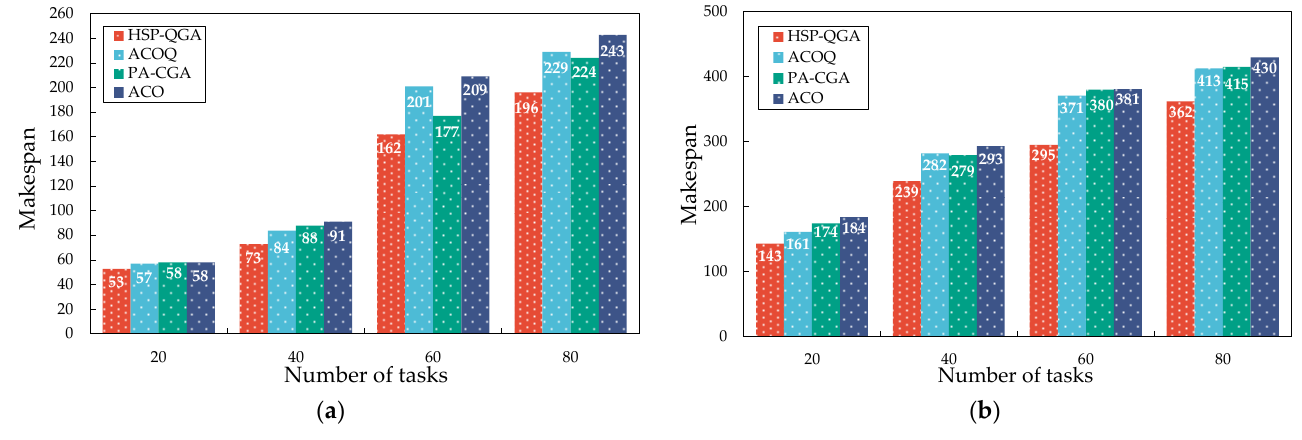
Figure 10. Comparison of scheduling lengths for different numbers of tasks: ( a ) CCR = 0.1; ( b ) CCR = 4.